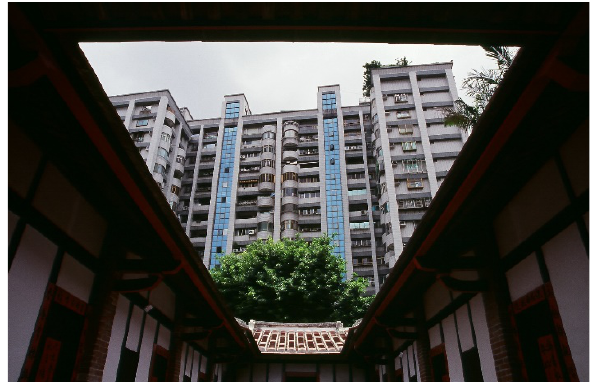
Figure 4: The Lee Family’s House in Luchou District has been a well known historic site in New Taipei City.